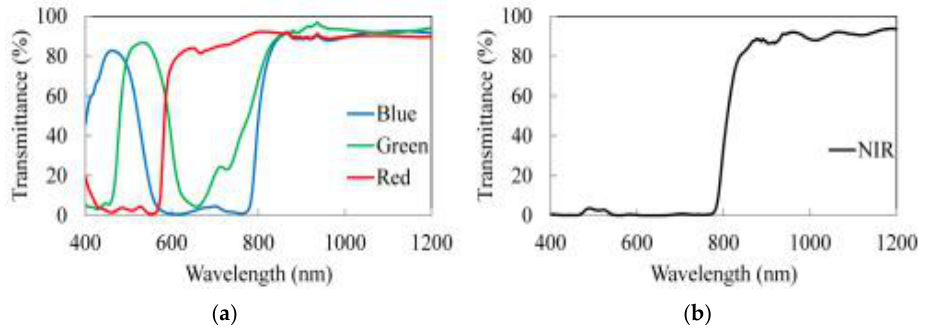
Figure 42. Transmission spectra of ( a ) red, green, and blue filters, and ( b ) near-infrared (NIR)